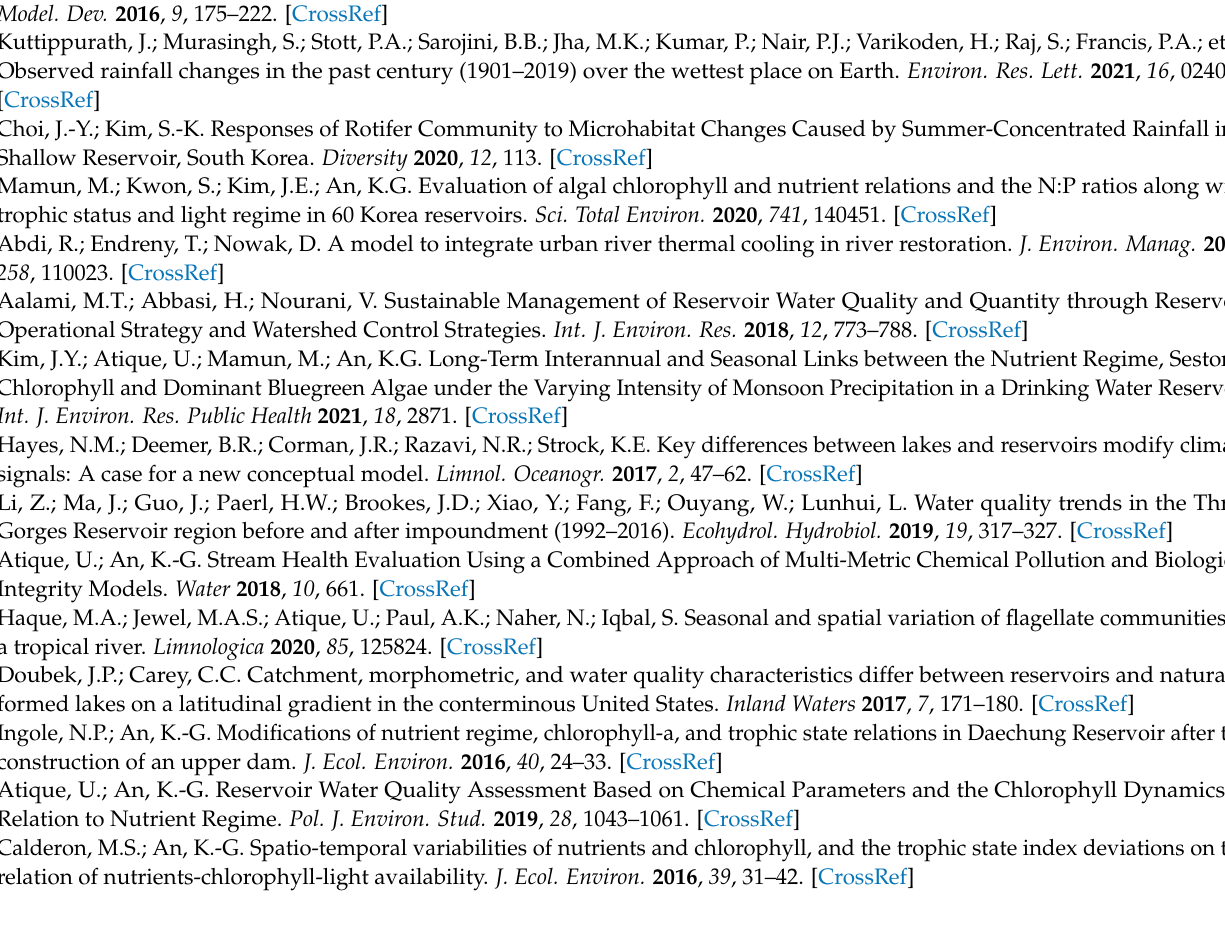
S1: Empirical relationships between water quality parameters in the three precipitation year groups, Table S2: Principal component analysis of water quality and hydrological parameters in drought, flood and normal precipitation